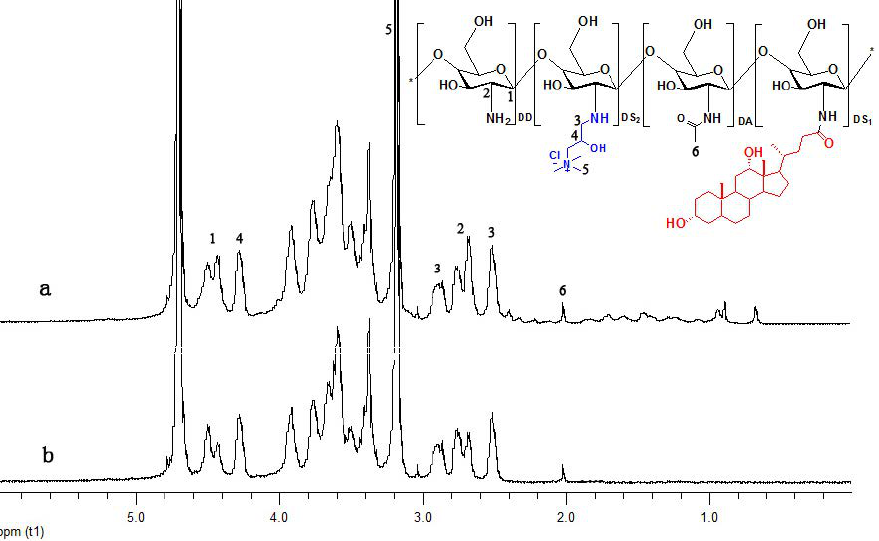
Figure 2. Spectra of chitosan derivatives analyzed by 1 H NMR: ( a ) HT 42 − CS-DCA 4.2 ; ( b ) HT − CS.